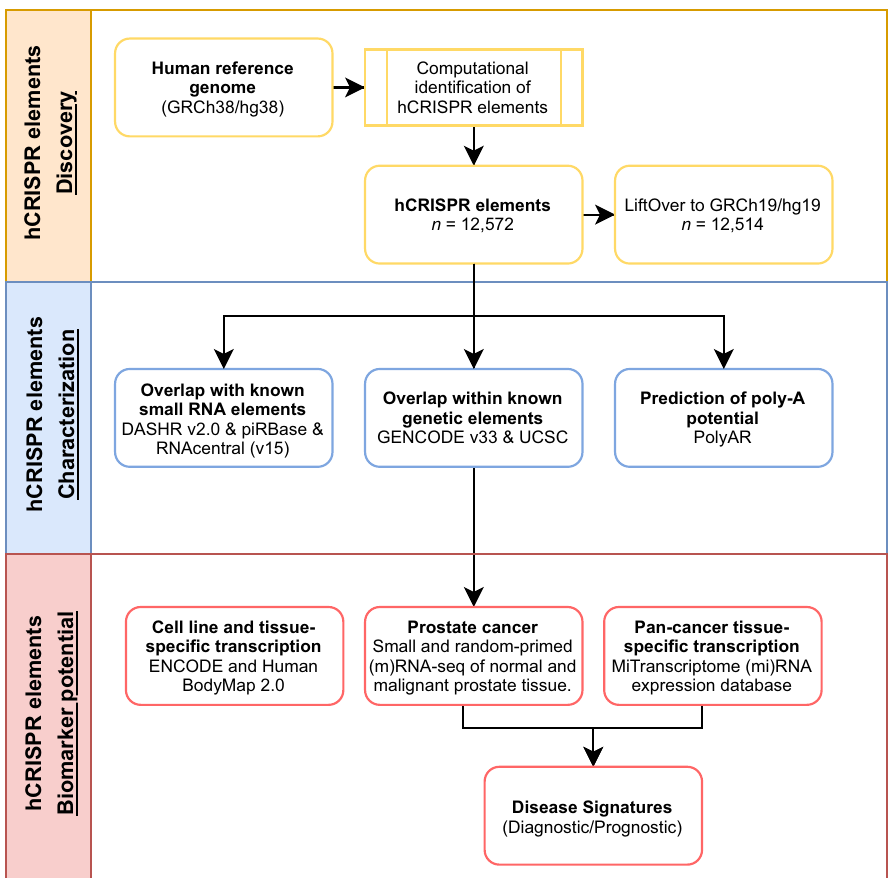
Fig. 1 Overview of study design to detect and characterize the hCRISPRs. Schematic fl owchart highlighting the major steps of the in silico approach as employed in this study. The major steps can be grouped as the following; identi fi cation of CRISPRs in the human reference genome (GRCh38); genomic characterization of the identi fi ed hCRISPRs ( n = 12,572); expression and the discovery of a diagnostic potential for the hCRISPRs in cell lines, distinct human tissues (Illumina Bodymap 2.0 and DASHR 2.0), prostate cancer (NGS-ProToCol), and a pan-cancer (localized) cohort